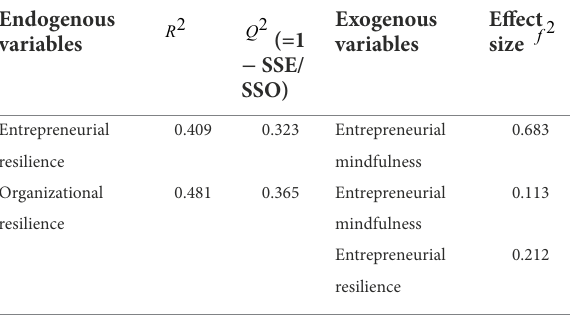
TABLE 8 Predictive relevance and effect size.